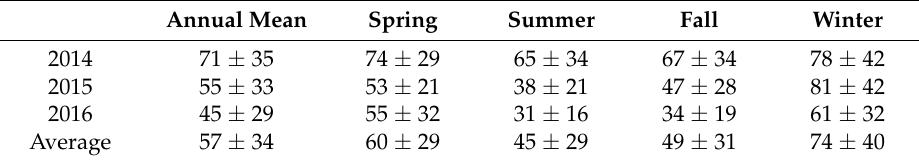
Table 1. Annual and seasonal average fine particulate matter (PM 2.5 ) concentrations during the study period ( µ g/m 3 , mean ± SD, calculated from daily